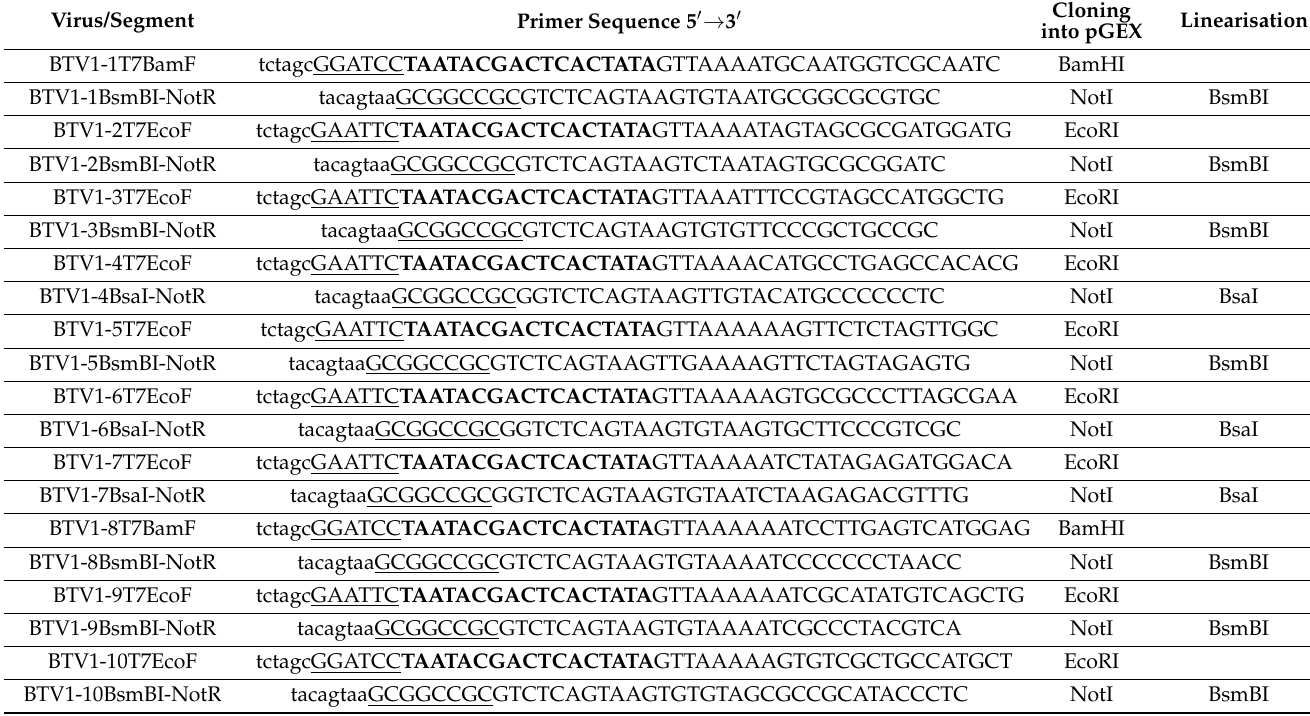
Table 1. Primers designed for PCR amplification of full-length cDNAs of genome segments 1–10 of BTV-1, for cloning into the pGEX-4T-2 plasmid. The minimal T7 promoter in the forward primer is shown in bold. Restriction enzyme used to facilitate cloning into the pGEX-4T-2 plasmid are underlined. Enzyme used to linearise the plasmid before T7 transcription is shown in the column to right of the table.